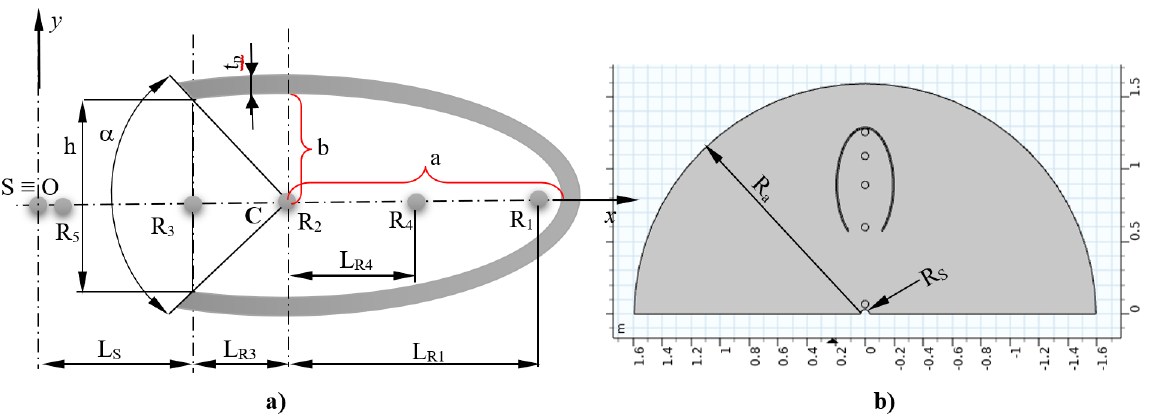
Figure 1. Schematic of the model of the 2D studied object and the acoustic space: ( a ) scheme of the studied elliptical sector with the basic dimensions and location of the control areas, ( b ) scheme of the acoustic space with the location of the elliptical sector and the acoustic source.